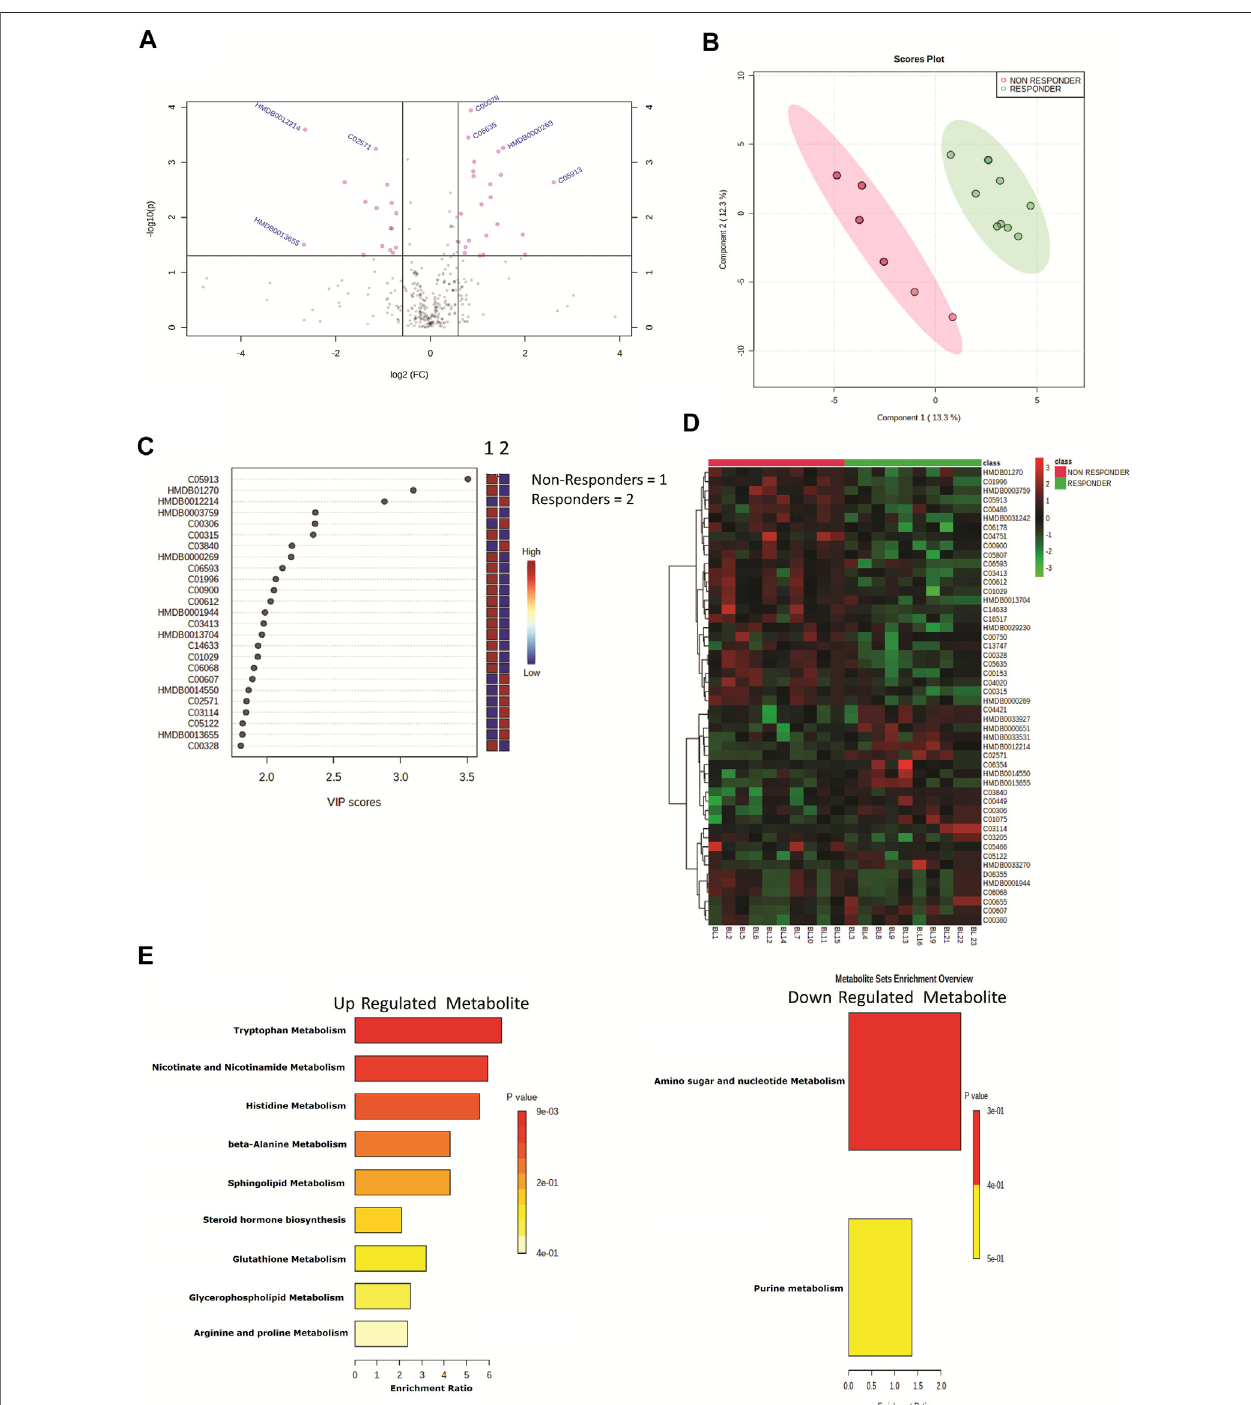
FIGURE 1 | (A) Volcano plot showing differentially expressed metabolites in DAA nonresponders vs. DAA responders at baseline. Pink dots are signi fi cant at p < 0.05. (B) Partial least square discriminant analysis (PLSDA) showing clear segregation of DAA nonresponders and DAA responders at baseline based on the metabolome pro fi le of patients. Pink dots correspond to nonresponders, and green dots correspond to responders. (C) Variable importance in projection (VIP) plot displaying the top 20 most important metabolite features identi fi ed by PLSDA at baseline. Colored boxes on the right indicate relative concentration of the corresponding metabolite between DAA nonresponders vs. DAA responders. (D) Heat map and hierarchical clustering analysis of top 50 metabolites are capable to segregateDAAnonresponders(redbar)fromDAAresponders(greenbar)atbaseline.Theexpressionisgivenasred (cid:1) upregulated,green (cid:1) downregulated,andblack (cid:1) unregulated. (E) KEGG pathway analysis of upregulated and downregulated metabolites in DAA nonresponders as compared to those in DAA responders at baseline.